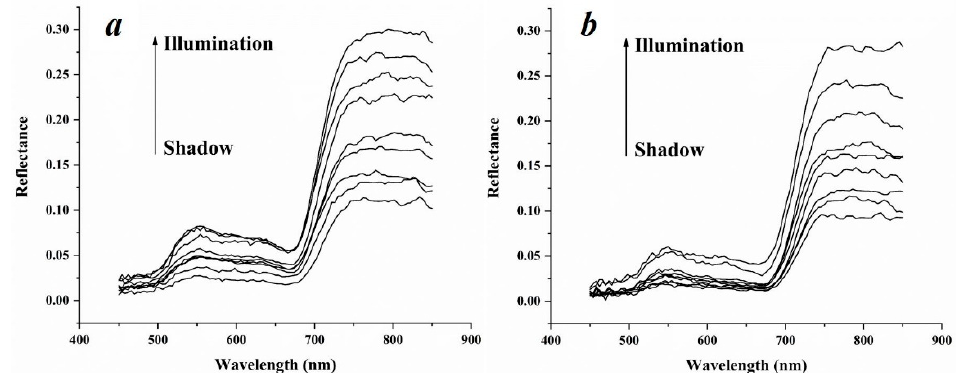
Figure 3. Reflectance spectra of Pinus ( a ) and Larix ( b ) with di ff erent proportions of shadow and illumination. The reflectance generally decreased as the proportion of shaded canopy increased.